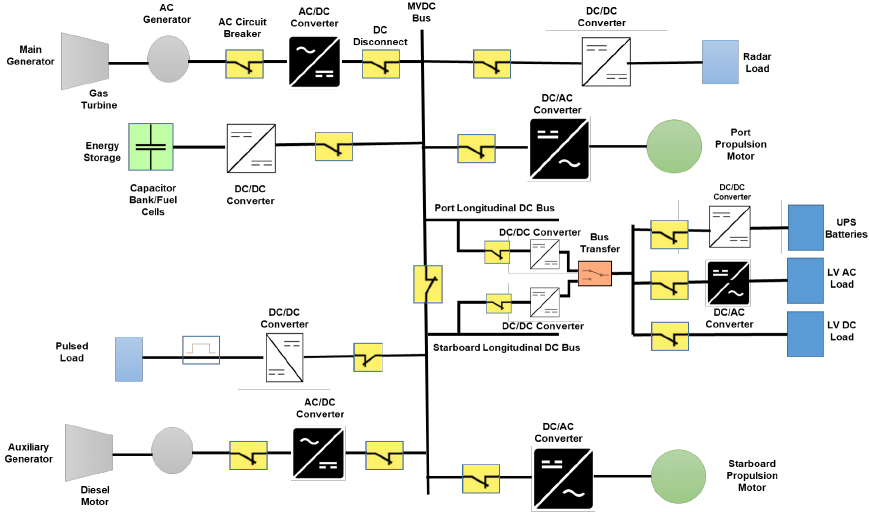
Figure 1. Simplified concept of MVDC SPS system diagram with power electronics applications [4].